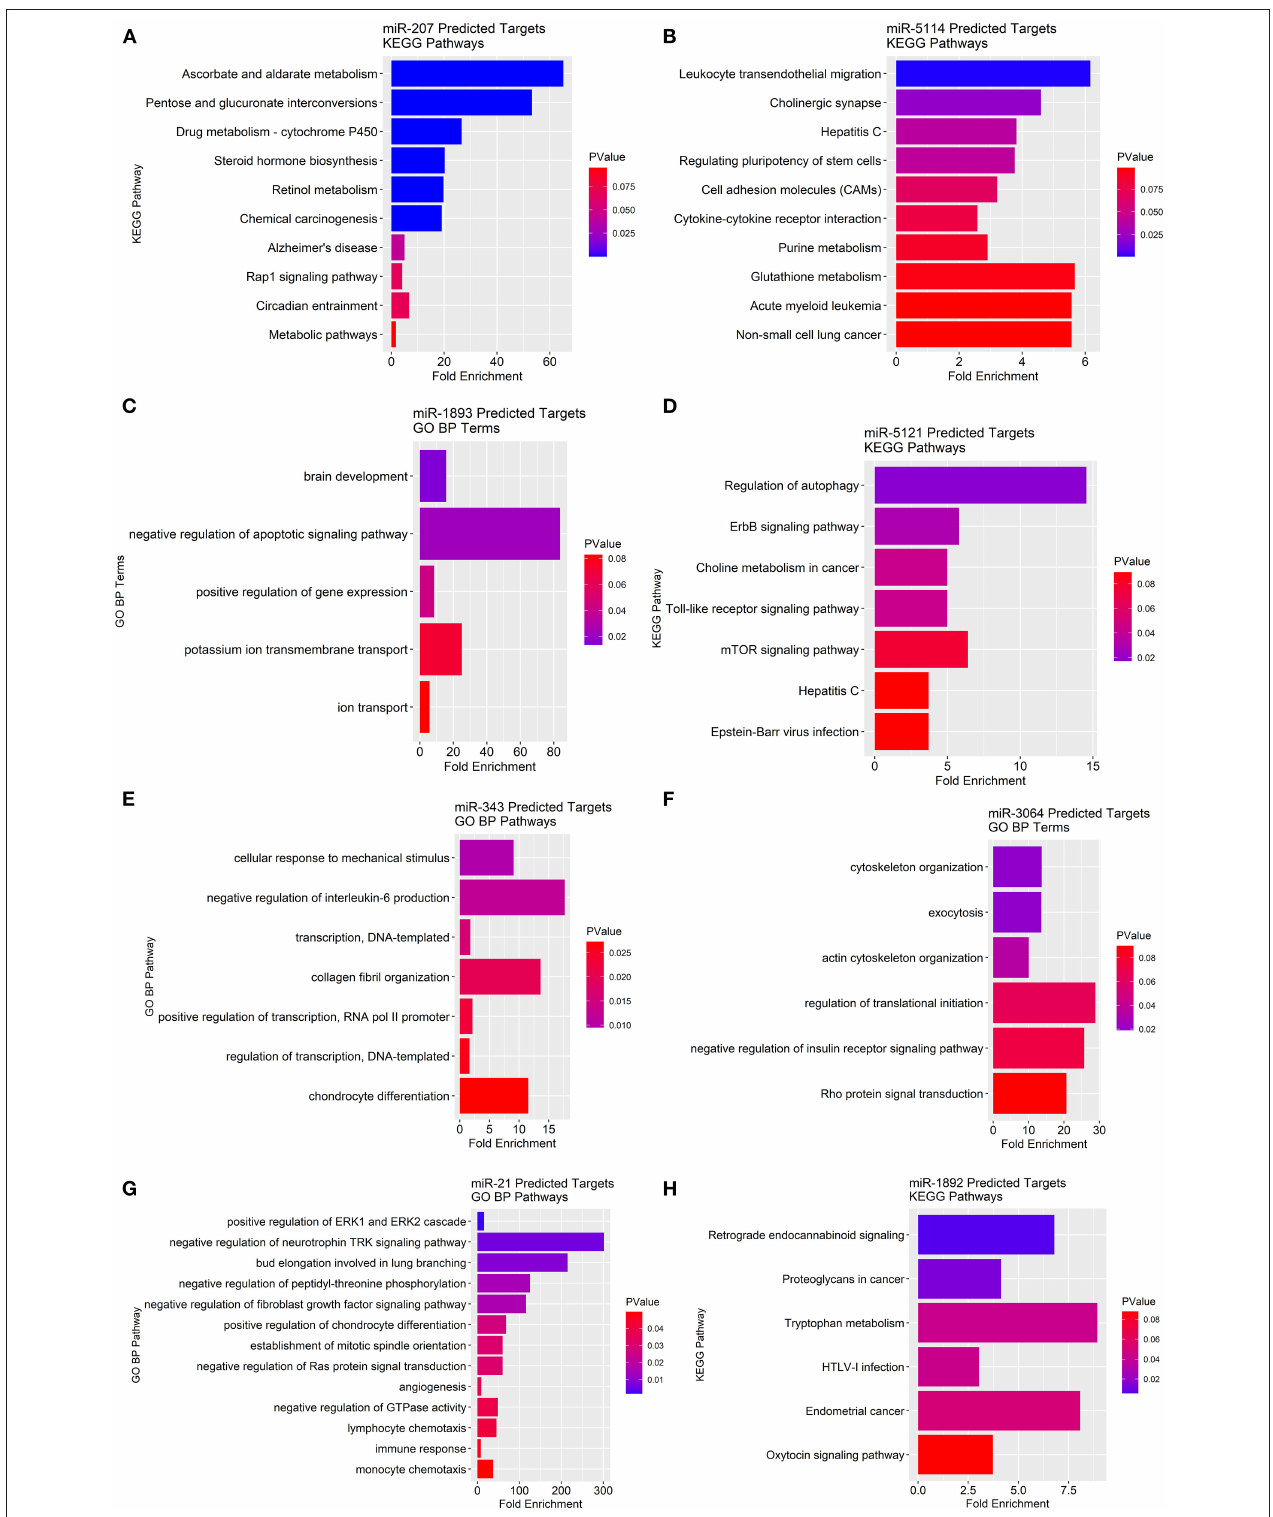
FIGURE 6 | KEGG pathway and gene ontology analyses of predicted miRNA gene targets in ChemR23 KO obese and ChemR23 KO lean mice. Predicted miRNA KEGG pathway or gene ontology (GO) biological process (BP) targets are plotted by fold enrichment and colored by p-value, with red denoting the least